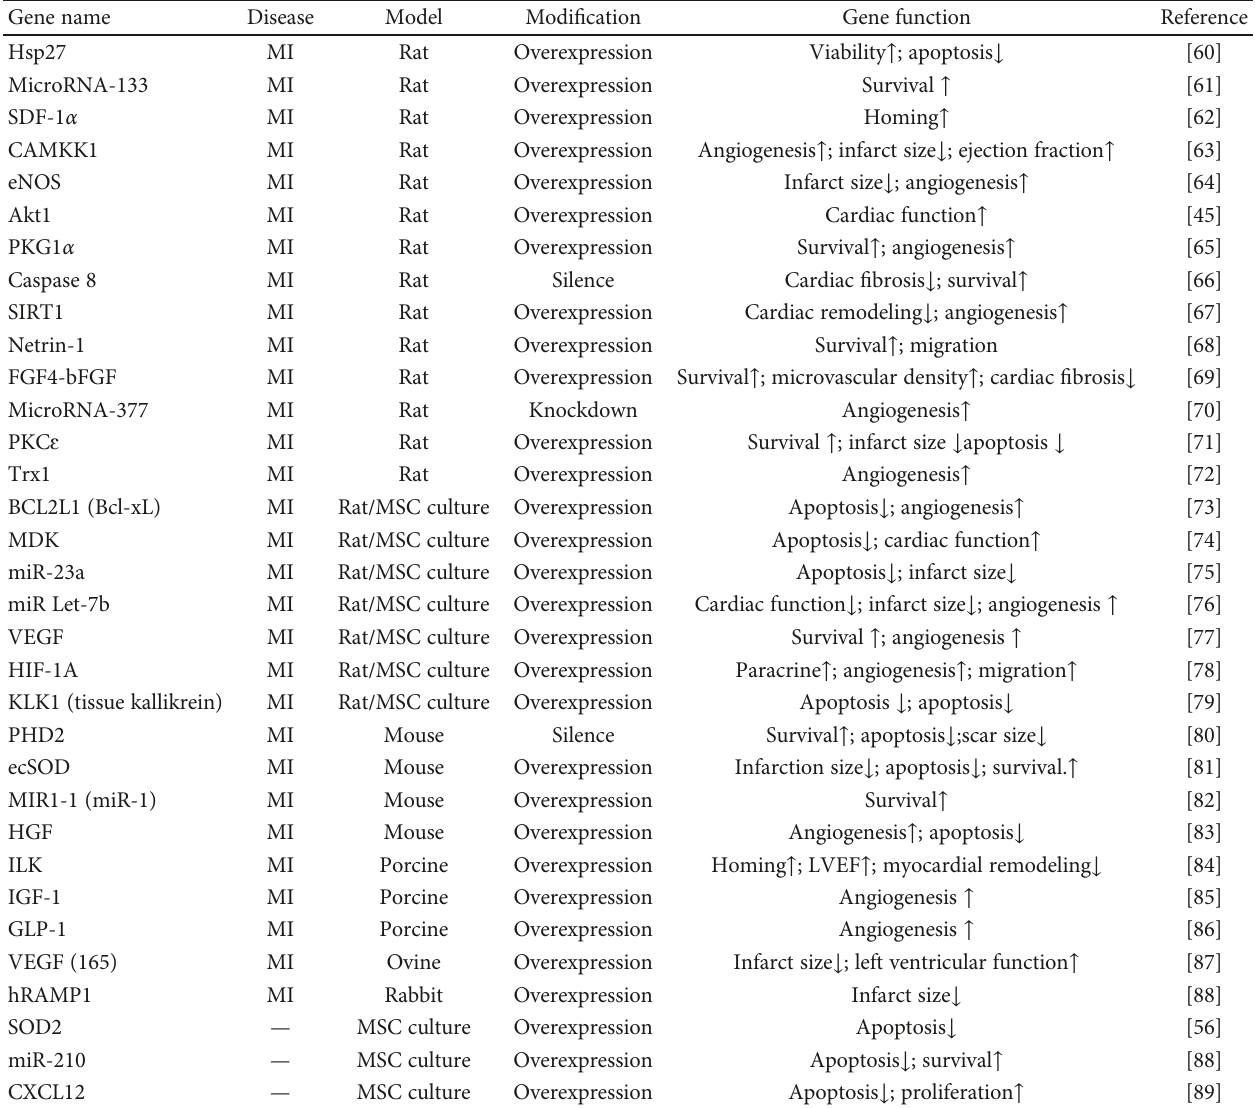
Table 2: Gene modi fi cation in MSC transplantation for treating